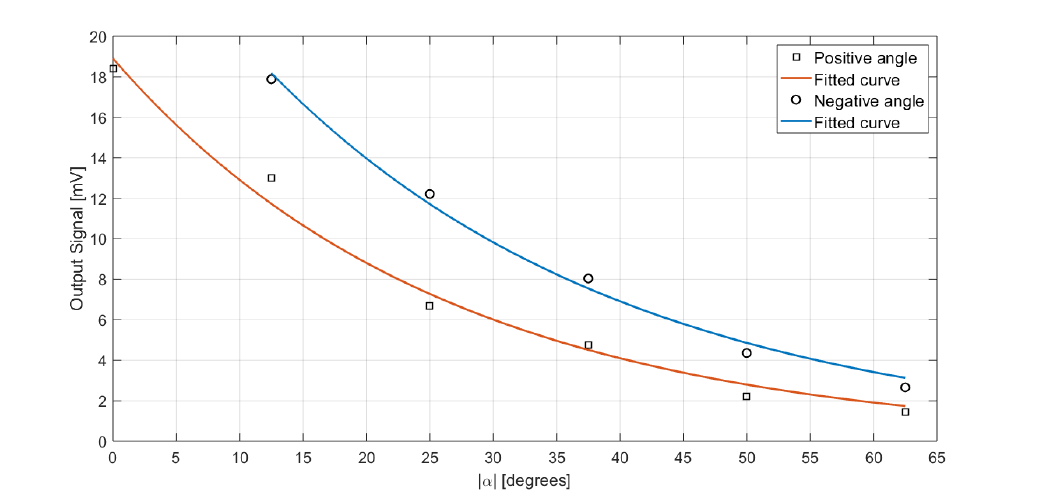
Figure 13. Signal in the case of a person standing at d = 1 m from the sensor for different values of α .